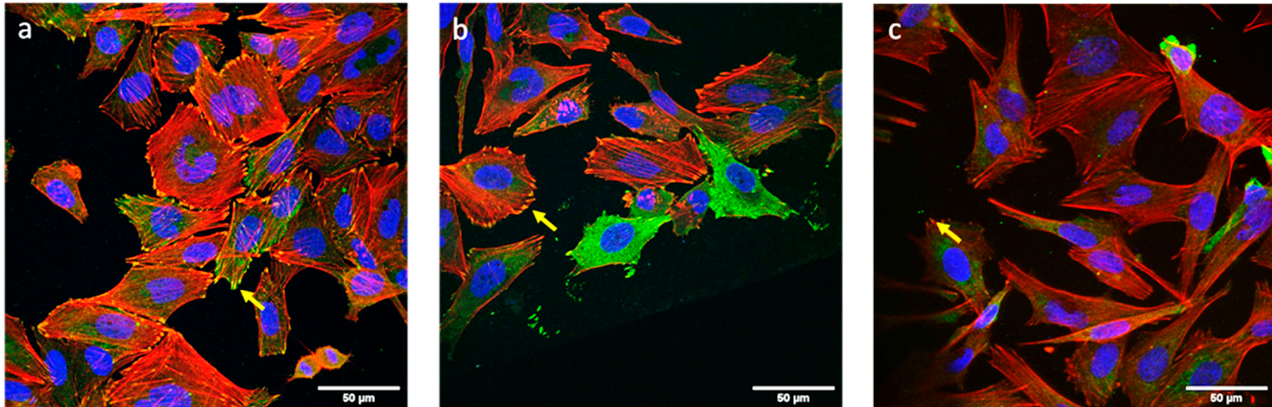
Figure 5. Saos-2 cells adhered to the surface of the pristine alloy ( a ), ZnO thin film ( b ), and ZnO nanosheets ( c ) after 3 days in culture. Stress fibers (actin; red), vinculin (green) and nuclei (DNA; blue) can be observed. Focal contacts (yellow arrows) appear as yellow spots due to the overlay of actin and vinculin signals.